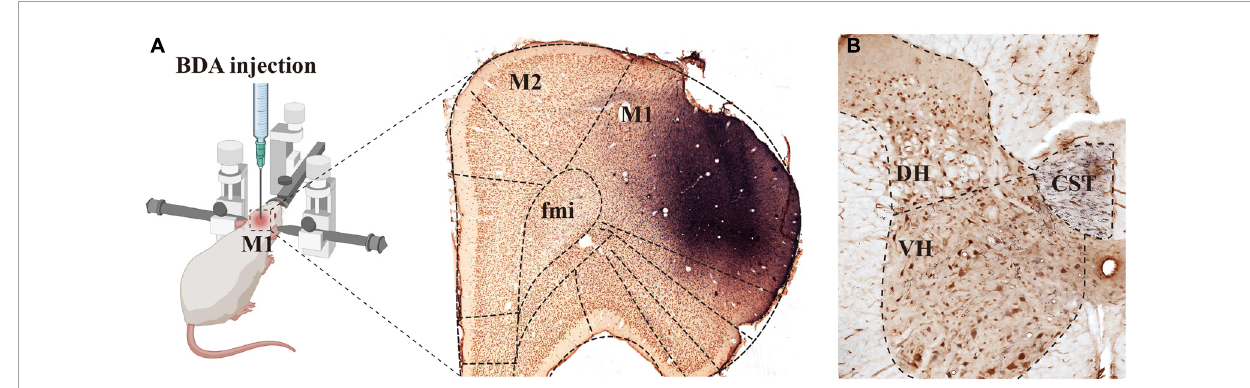
FIGURE1 Biotinylated dextran amine (BDA) was injected into M1 and the labeled fibers were distributed in the spine. Image [ (A) , left panel] shows the rats that were fixed on the operating table in the prone position and placed on a stereotaxic apparatus, and BDA solution was injected into the M1 region of the rat cerebral cortex. The (right panel) in image (A) shows the immuno-light microscopy (LM) images at the injection sites, BDA solution (blue) was absorbed by pyramidal cells (brown) of the M1 region. (B) Shows that BDA+ fibers crossed to the ventral region of the dorsal funiculus on the opposite side of the injection site, the crossed CST extended into the spinal gray matter, and most of them were distributed in the deep dorsal horn and the ventral horn. M1, primary motor cortex; M2, second motor cortex; fmi, forceps minor of the corpus callosum; CST, corticospinal tract; DH, dorsal horn; VH, ventral